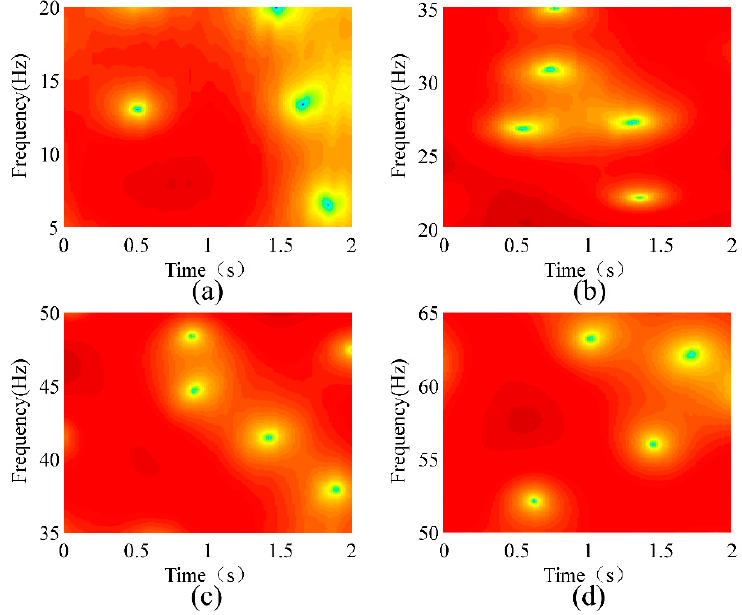
Figure 15. STFT analysis of the conductor’s vibration responses at a wind velocity of 4.5 m/s. ( a ) 1st Mode; ( b ) 2nd Mode; ( c ) 3rd Mode; ( d ) 4th Mode.